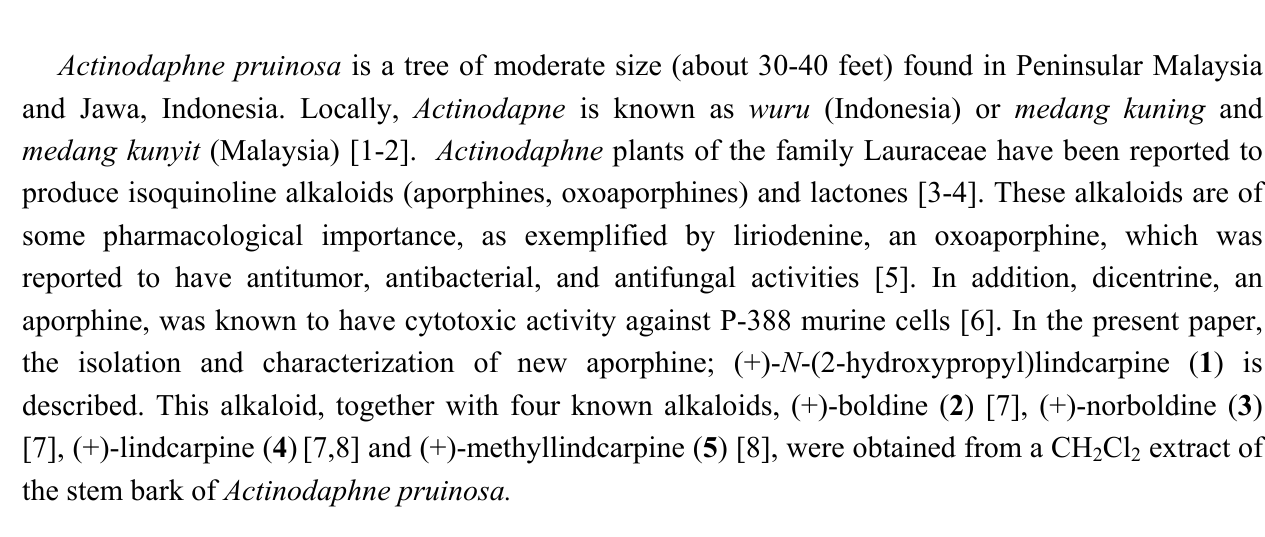
Figure 1. Alkaloids 1- 5 isolated from Actinodaphne pruinosa